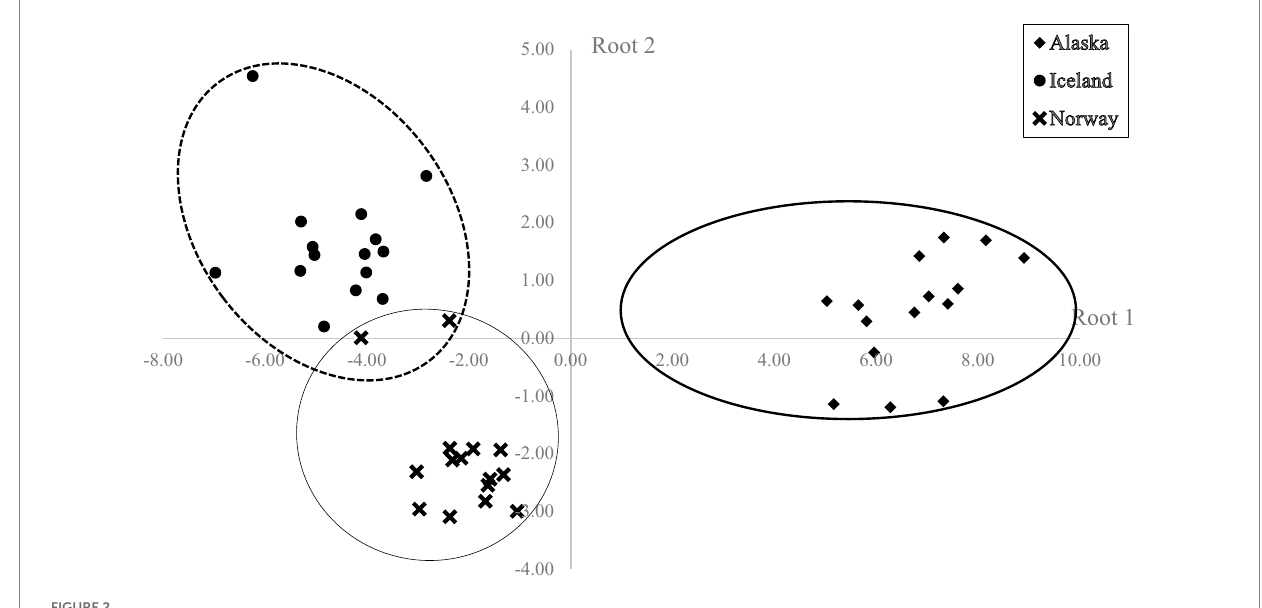
FIGURE 2 Plot of the discriminant functions (root 1 versus root 2) for the classification of cod’s